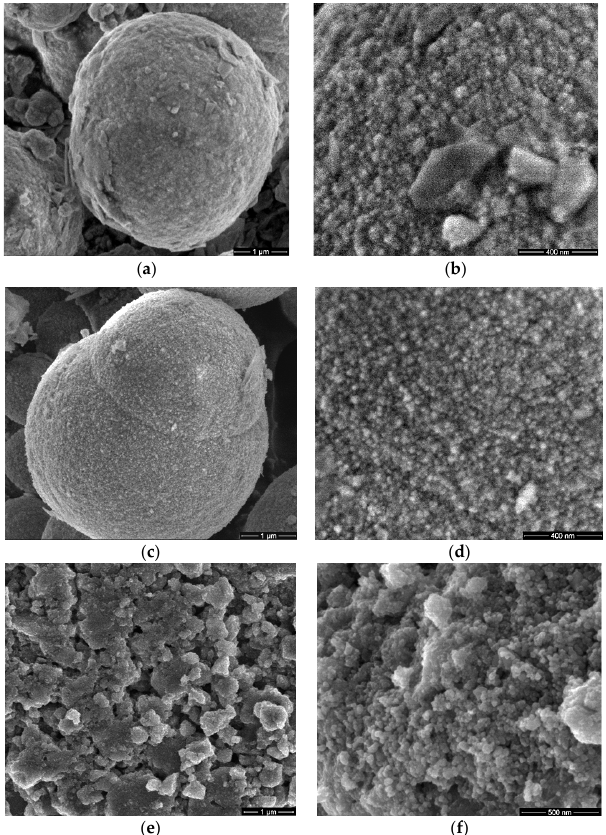
Figure 1. SEM images of ZnSe ( a , b ), ZnSe-TiO 2 ( c , d ) and TiO 2 ( e , f ).